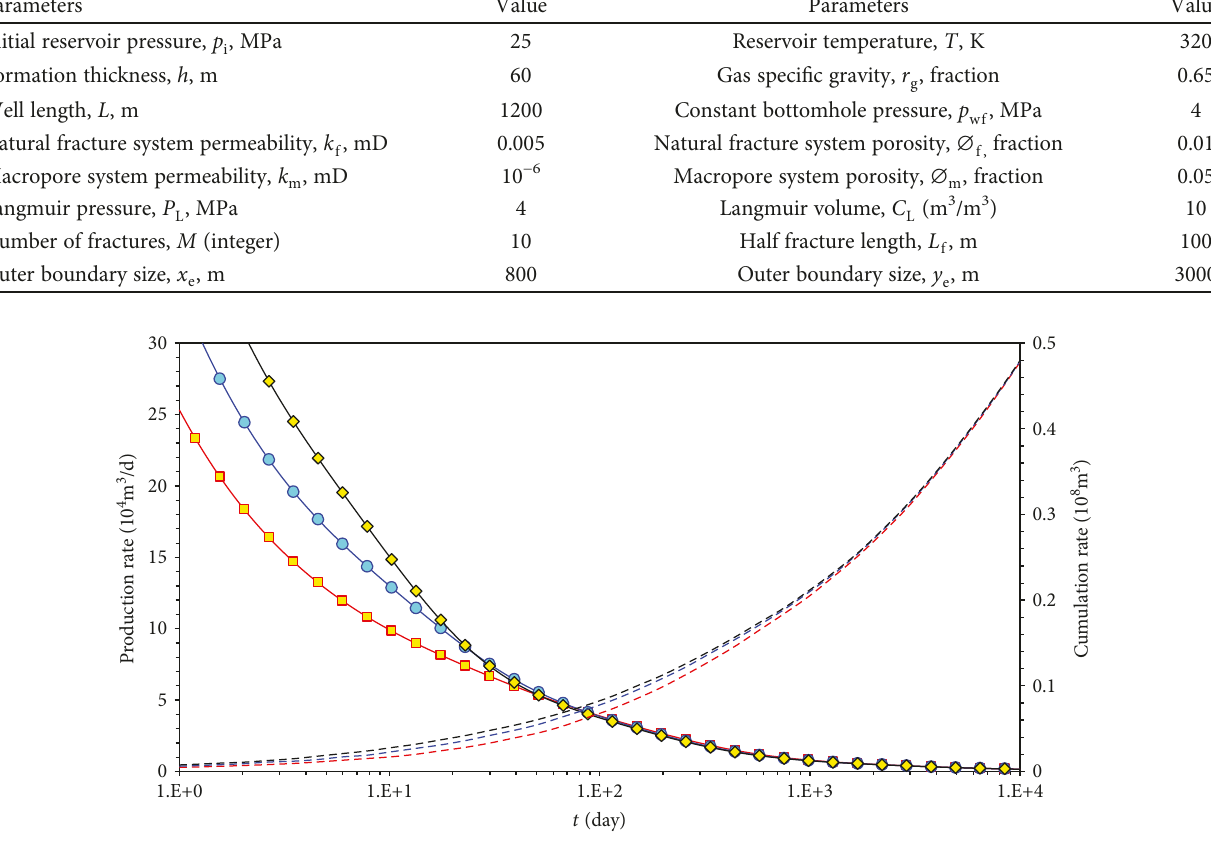
Table 1: Synthetic data used in the examples.